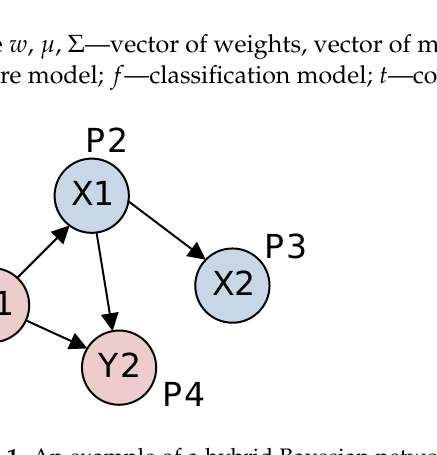
Figure 1. An example of a hybrid Bayesian network, blue nodes are discrete data, pink nodes are continuous